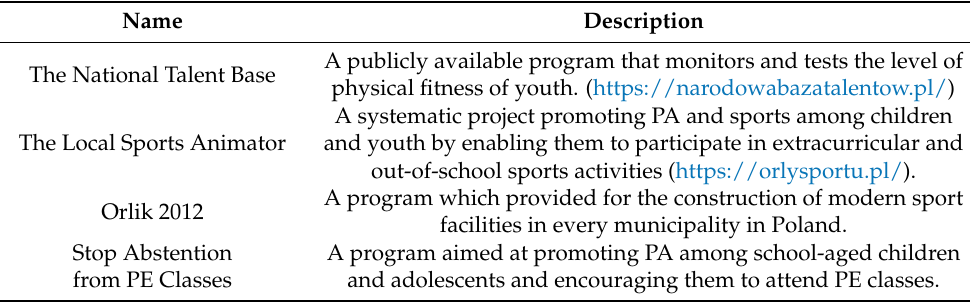
Table 4. Selected PA-related programs and interventions implemented in